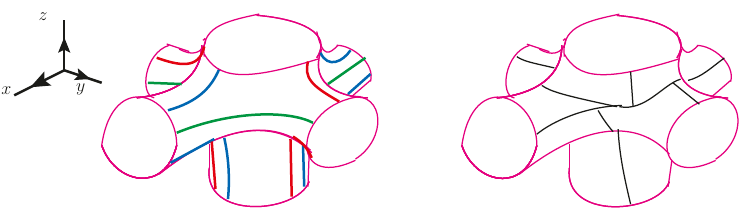
Figure 5 . The left panel shows a Heegaard diagram for the 3-torus. The x; y and z directions have to be periodically identi(cid:12)ed. The Heegaard surface is based on a lattice constructed from a cube whose sides have been identi(cid:12)ed pairwise. This surface is of genus three: there is a punctured sphere corresponding to one vertex of the triangulation and three one-handles corresponding to the three edges of the lattice. There are three two-handles corresponding to the three pairs of identi(cid:12)ed sides. The attaching curves are shown in blue, green and red. To obtain the Heegaard surface for a lattice with more cubes we just need to glue more of the basic building blocks, shown in the panel, to each other. The right panel shows a choice for a B 1 basis, where for clarity we have omitted vacuum loops and the over-crossing graph F u